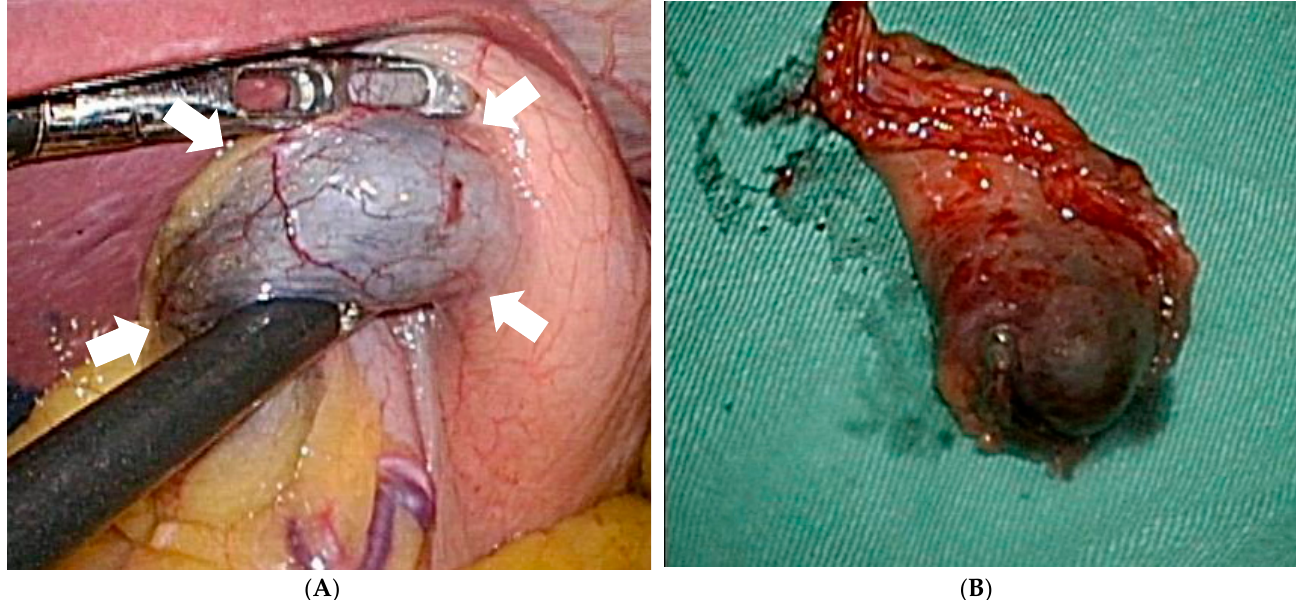
Figure 2. The tattoo is inspected directly from serosa (white arrows) during laparoscopic surgery without spillage ( A ) and then the tumor is resected completely ( B ).